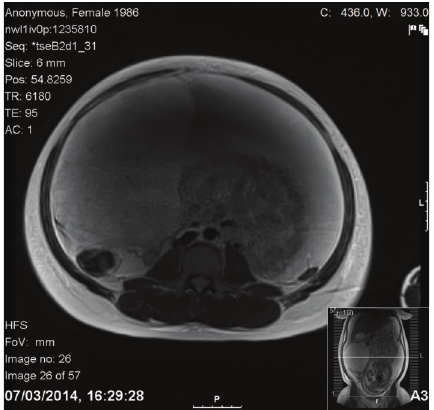
Figure 3: Axial T2-weighted MR image revealing the encapsulated right adnexal